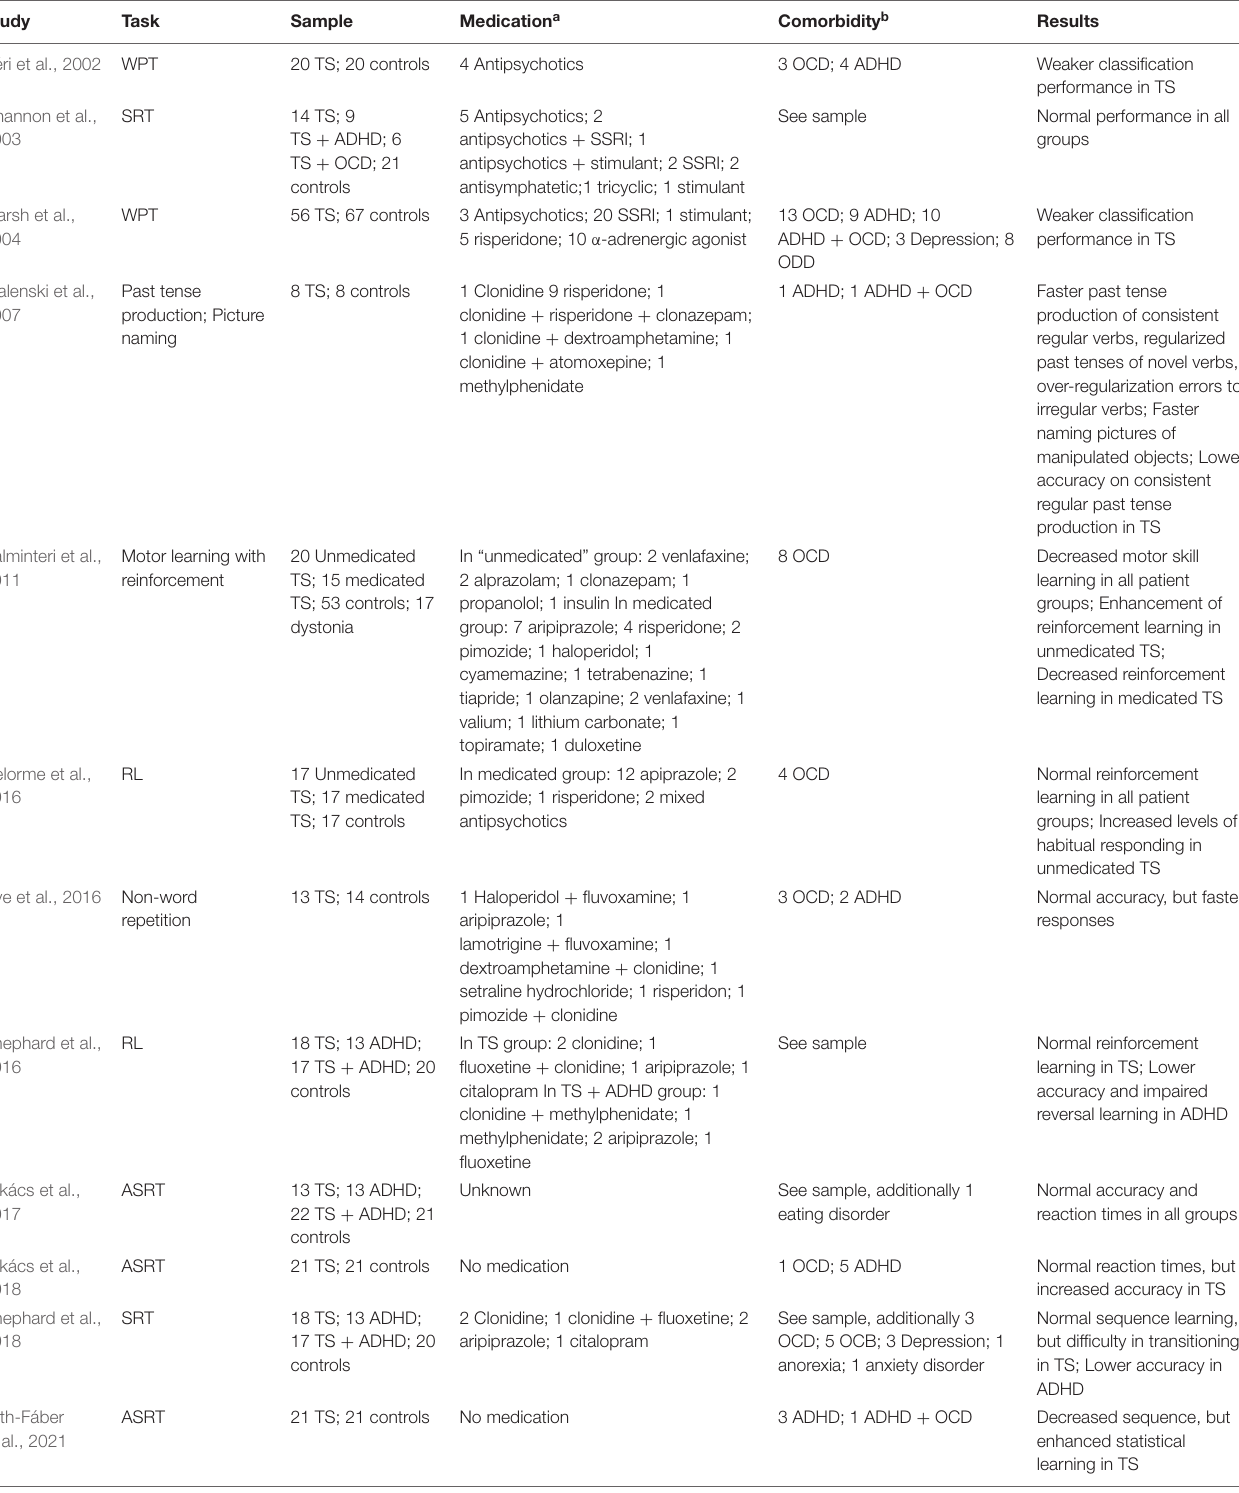
TABLE 1 | Summary of studies